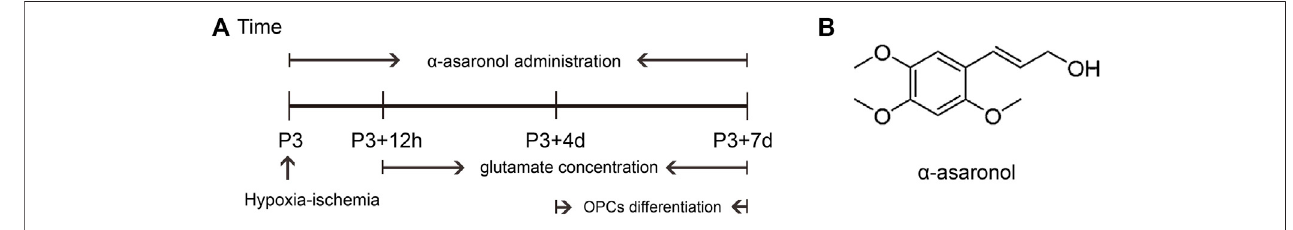
FIGURE 1 | Schematic diagram of the experimental design in vivo . (A) Schedule of animal experiments. (B) Molecular structure formula of α